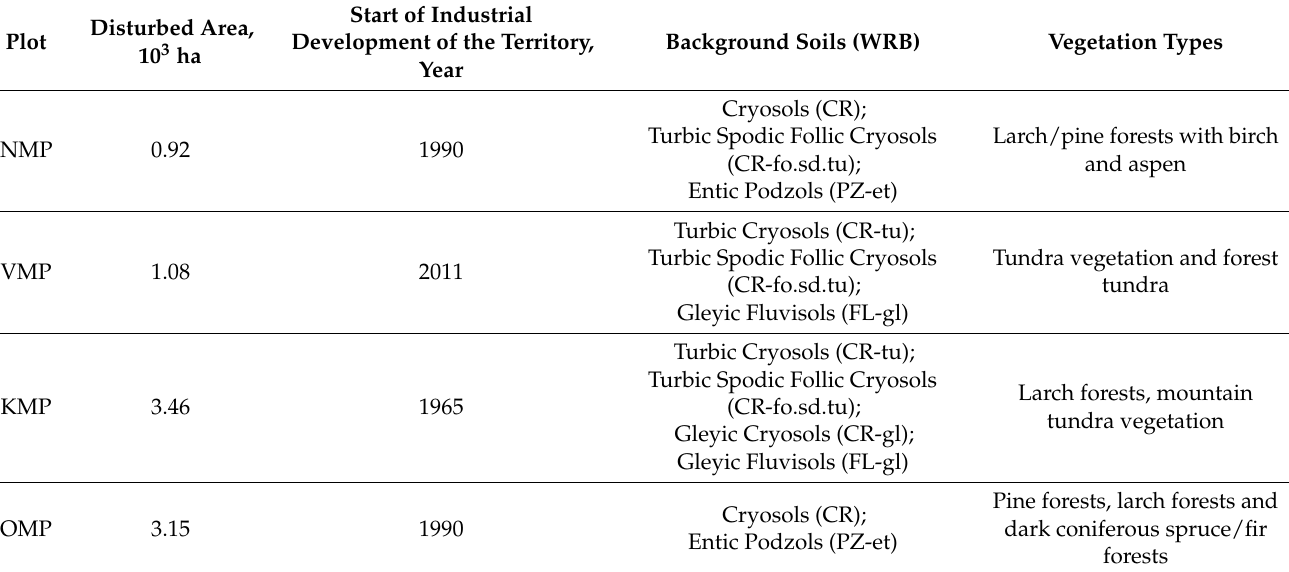
Table 1. Study area characteristics.